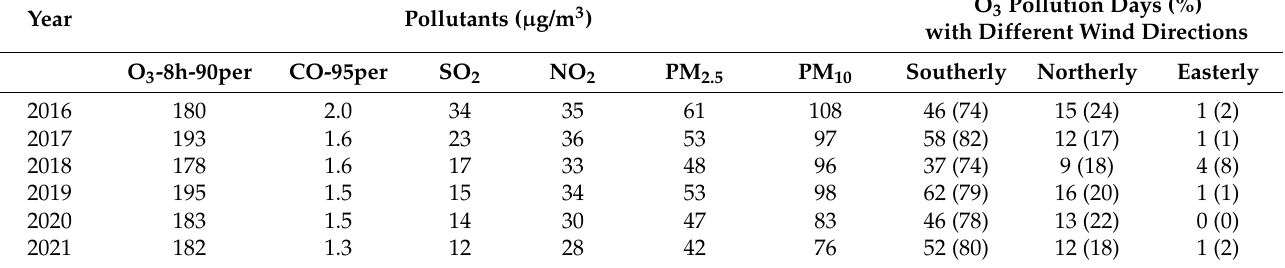
Table 1. Annual average concentrations of pollutants from 2016 to 2021 and O 3 pollution days for different wind directions in Tai’an during May–September from 2016 to 2021. The quantities in parenthesis represent the proportion of polluted days in a certain wind direction to the total polluted days.